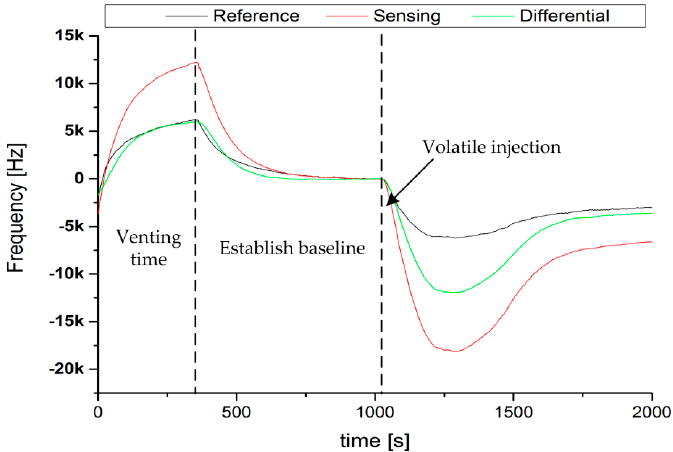
Figure 3. Surface Acoustic Wave Resonator (SAWR) responses obtained during a typical ratiometric measurement, (0.33 µ L Z9-14:OAc and 0.66 µ L E11-14:OAc) showing sensing, reference and difference signals of a PSB-coated dual sensor. The sensor response during venting and baseline establishment is also shown.